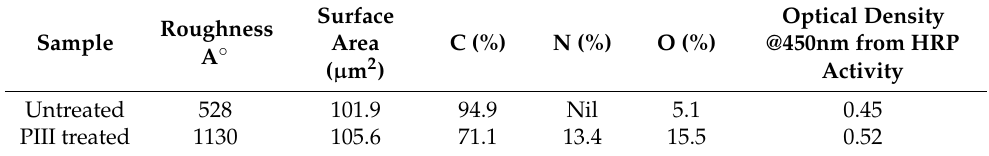
Table 10. Surface property influence on HRP immobilization after PIII treatment on UHMWPE.